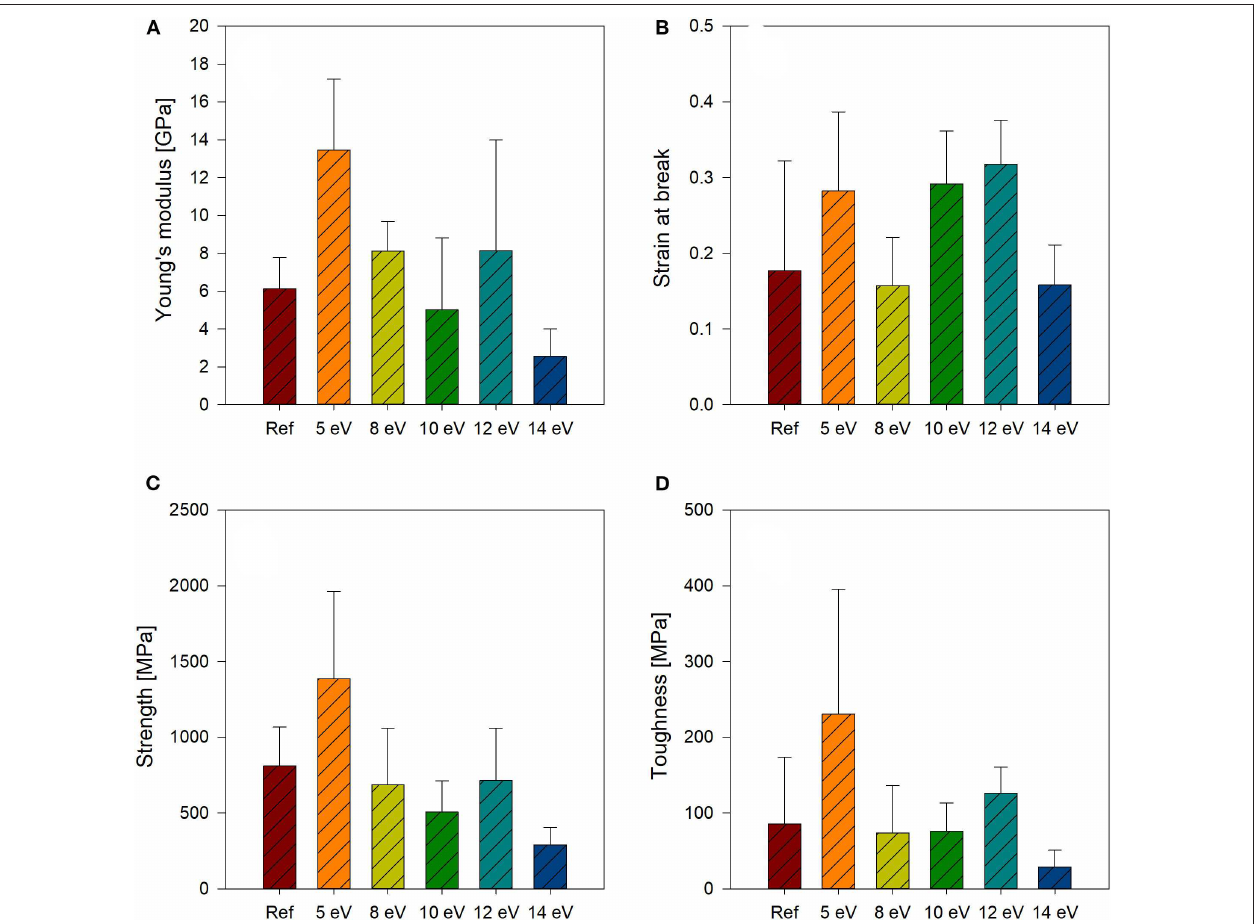
FIGURE 2 | Dependence of the Young’s modulus (A) , strain at break (B) , strength (C) and, toughness (D) of spider silk fibers on the Kinetic Energy (KE) of Supersonic Molecular Beam Epitaxy (SuMBE) implantation of C 60 molecules. A KE of 5eV allows to almost double the Young’s modulus, the strain at fracture and strength, while almost triple the toughness (here reported as the area under the stress-strain curve).